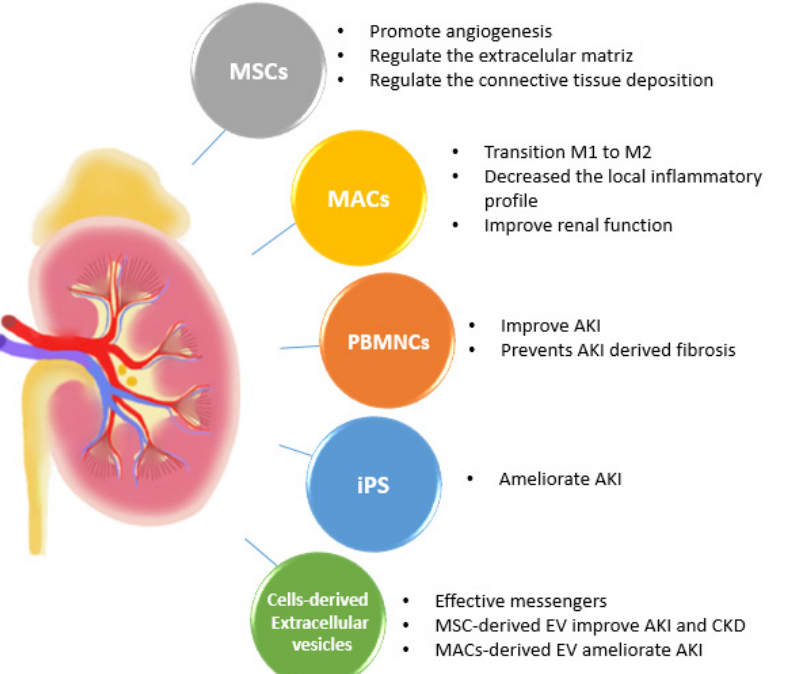
Figure 1. Top candidates to develop a cellular therapy against renal diseases and advances. Ad- vantages of mesenchymal stem cells, iPS, macrophages, peripheral blood mononuclear cells, and extracellular vesicles as a therapeutic use and novel strategies for renal treatment. MSCs: mesenchy- mal stem cells; MACs: macrophages; iPS: induced pluripotent stem cells; PBMNCs: peripheral blood mononuclear cells; EVs: extracellular vesicles.